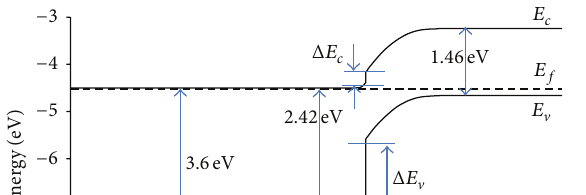
Figure 3: Current-voltage characteristics of thin-film CdS/CdTe cell. The measured experimental data is taken from [11].